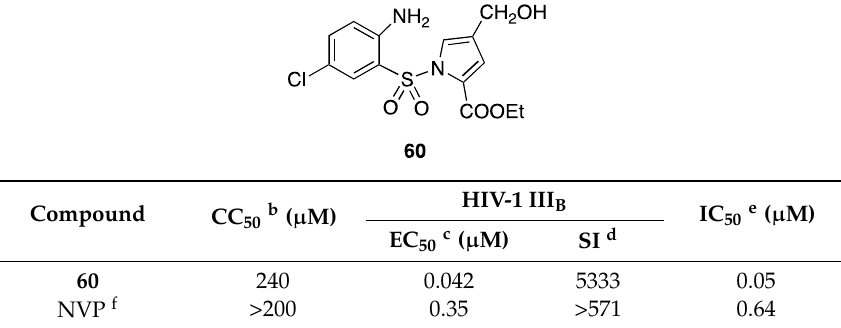
Table 7. Anti-HIV-1 activity of PAS 60 in MT-4 cells and against rRT a